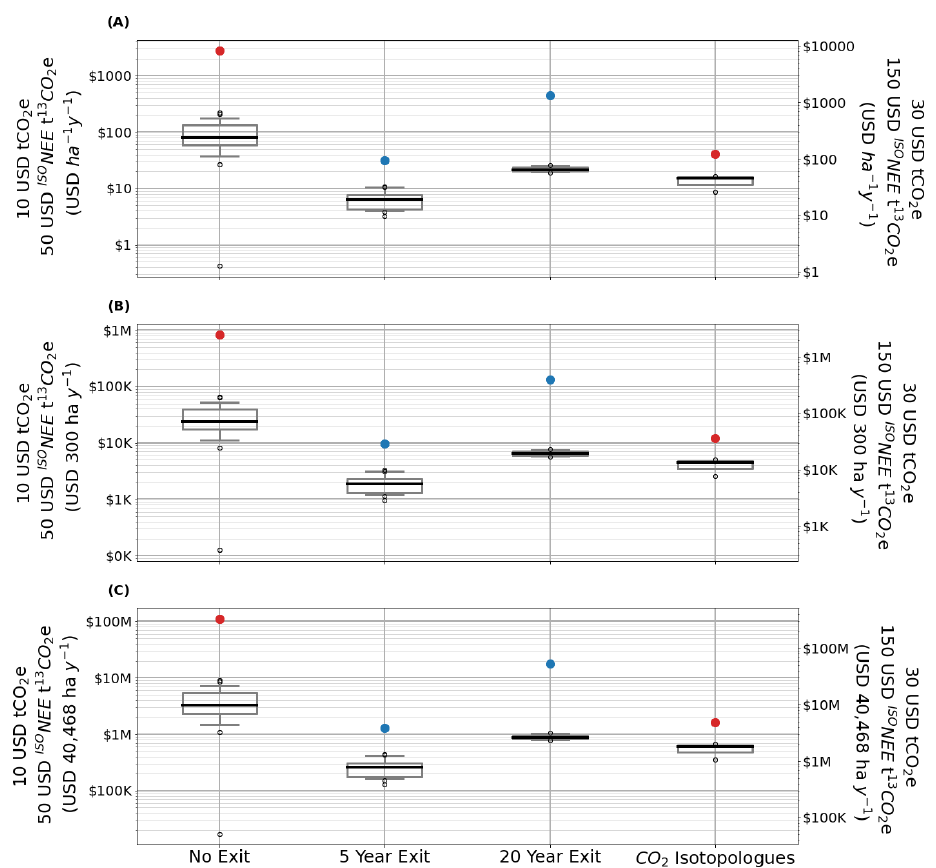
Figure 2. Yearly financial CO 2 and 13 CO 2 (or 12 C 18 O 16 O) box plots with median (black line), first and third quartiles (box), 5 and 95 percentiles (whiskers) and outliers (circles) per ha ( A ), extrapolated to Prospect Hill area (300 ha; ( B )) and extrapolated to 40,468 ha (100,000 acres; ( C )), based solely on numerical projection to illustrate potential project revenue with increasing land area, in logarithmic scale. The red points are accumulated values over the whole period; blue points are mean accumulated values at the end of exited projects (5 or 20 years, respectively). Left and right y -axis show different pricing scenarios (left: a ton of CO 2 is worth $10 and a ton of 13 CO 2 (or 12 C 18 O 16 O) $50; right: a ton of CO 2 is worth $30 and a ton of 13 CO 2 (or 12 C 18 O 16 O)